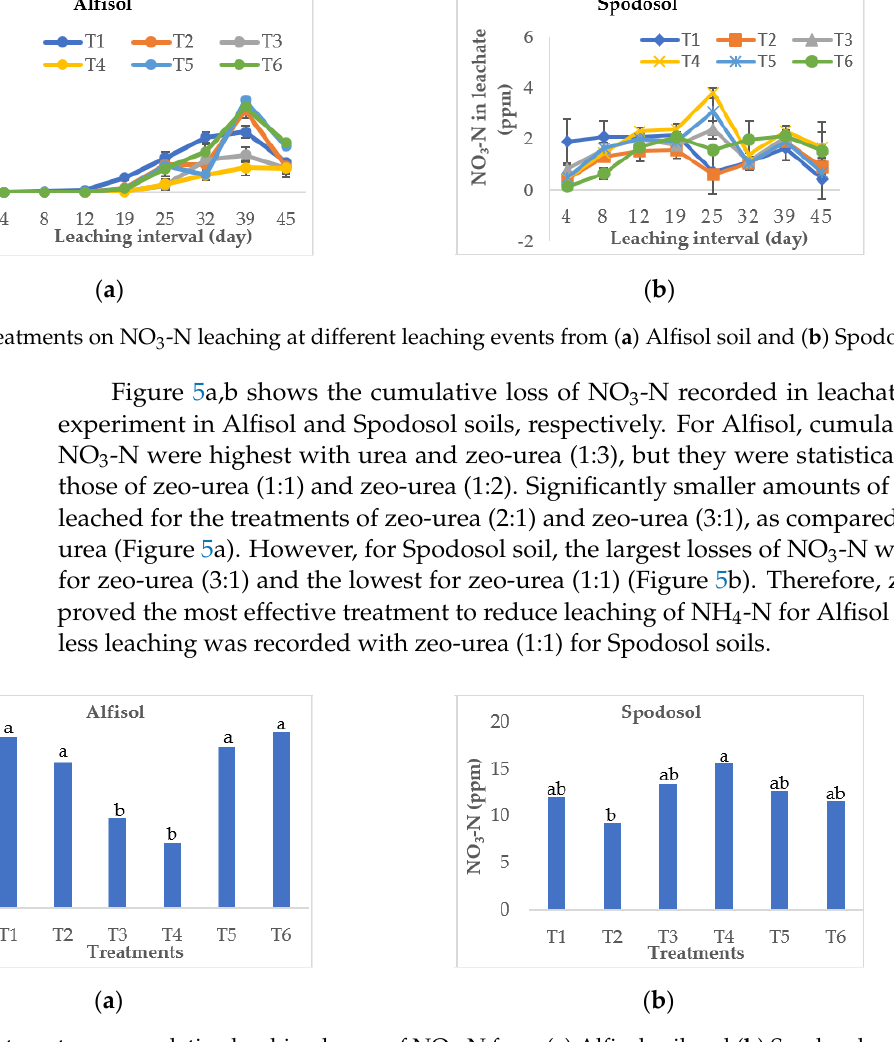
Figure 5. Effect of treatments on cumulative leaching losses of NO 3 ‐ N from ( a ) Alfisol soil and ( b ) Spodosol soil. Means with different letters indicate significant differences among treatments by Tukey’s test at p ≤ 0.05.